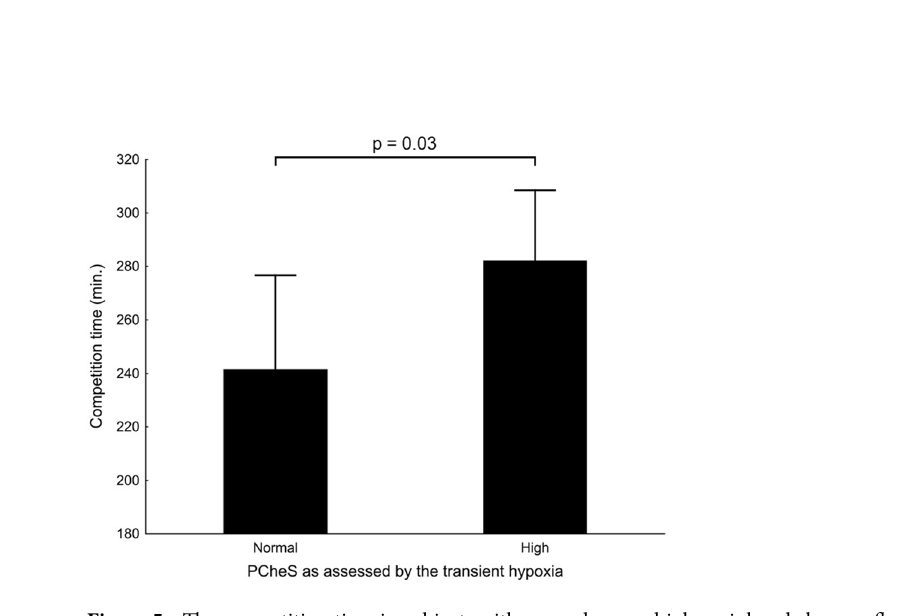
Figure 5. The competition time in subjects with normal versus high peripheral chemoreflex sensitivity as assessed with the transient hypoxia